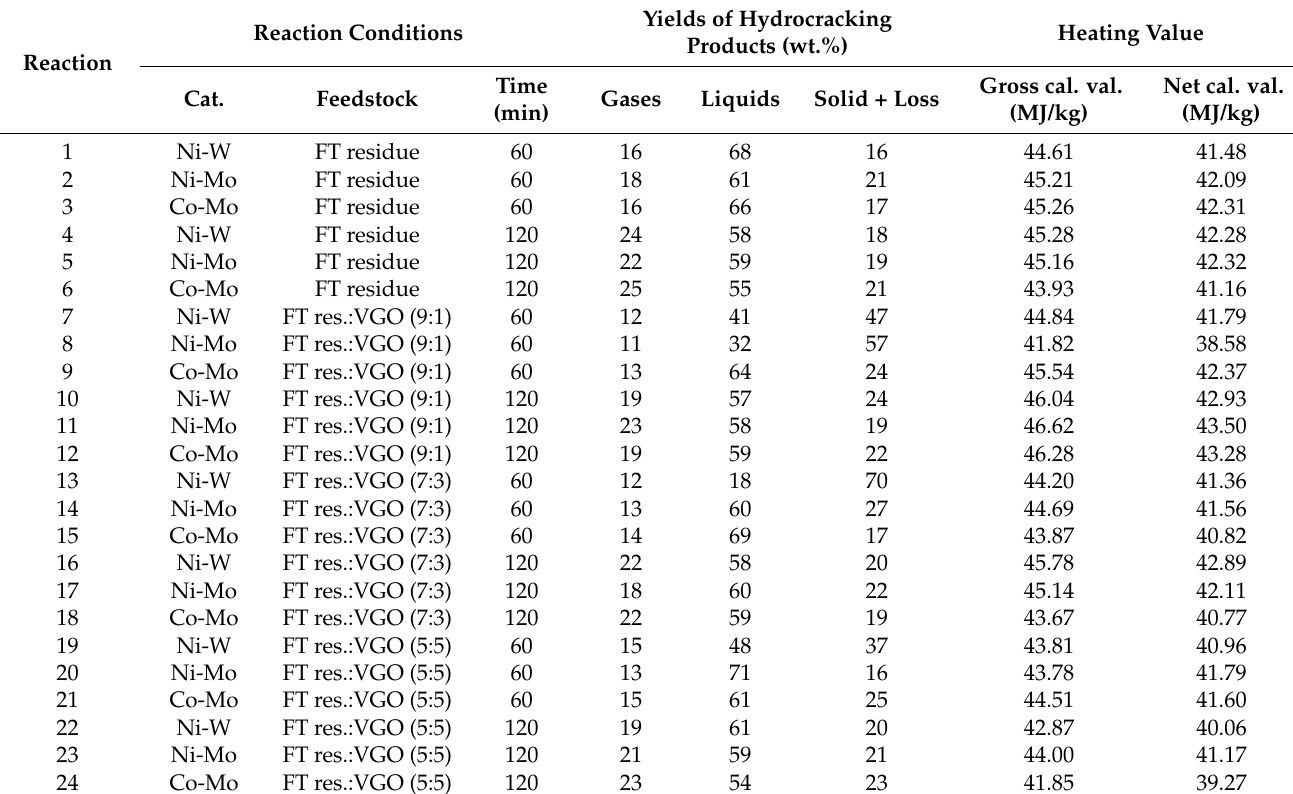
Table 1. The mass balance and heating values of the hydrocracking products at different reaction conditions.